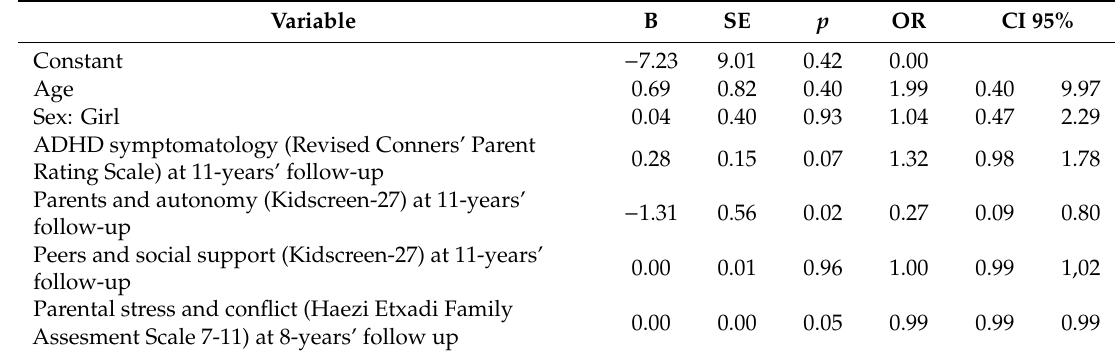
Table 3. Predictors of being a victim for the Gipuzkoa